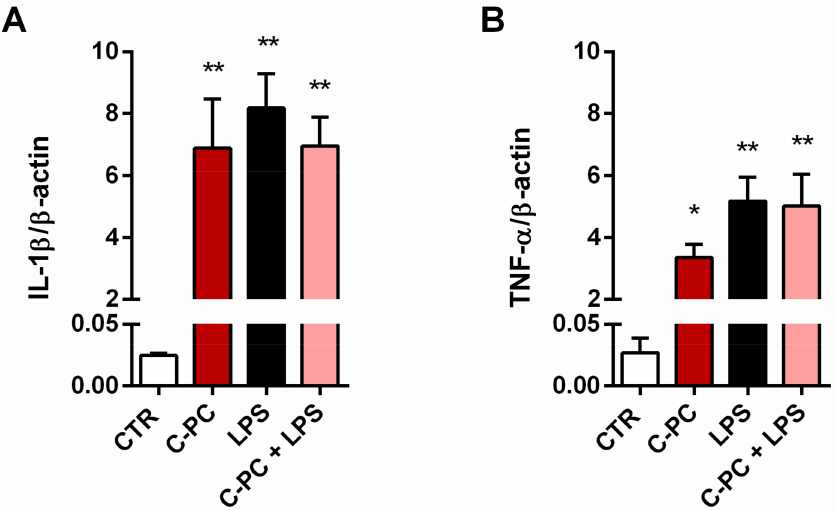
Figure 3. Effect of C-phycocyanin on cytokine production from cortical microglia. Microglia were cultured overnight in medium containing 10% of serum, which was replaced with serum-free medium before treatment with 100 µ g/mL C-PC, 100 ng/mL LPS, or their association for 6 h. IL-1 β ( A ) and TNF- α ( B ) mRNA levels were quantified by real-time PCR. Data are means ± SEM ( n = 3 in triplicate). * p < 0.05 and ** p < 0.01 versus control cells (CTR). One-way ANOVA followed by Holm–Sidak’s